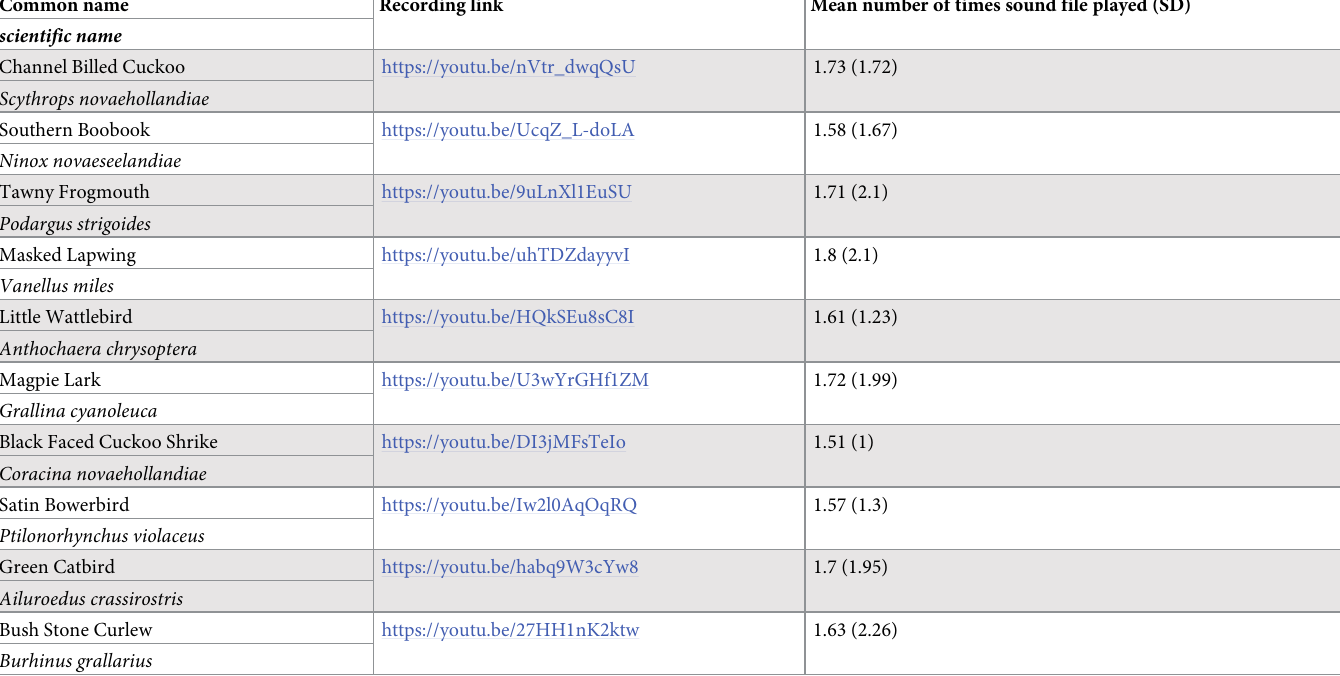
Table 1. Represented Australian native bird species, links to their recorded calls, and average number of times these calls were listened